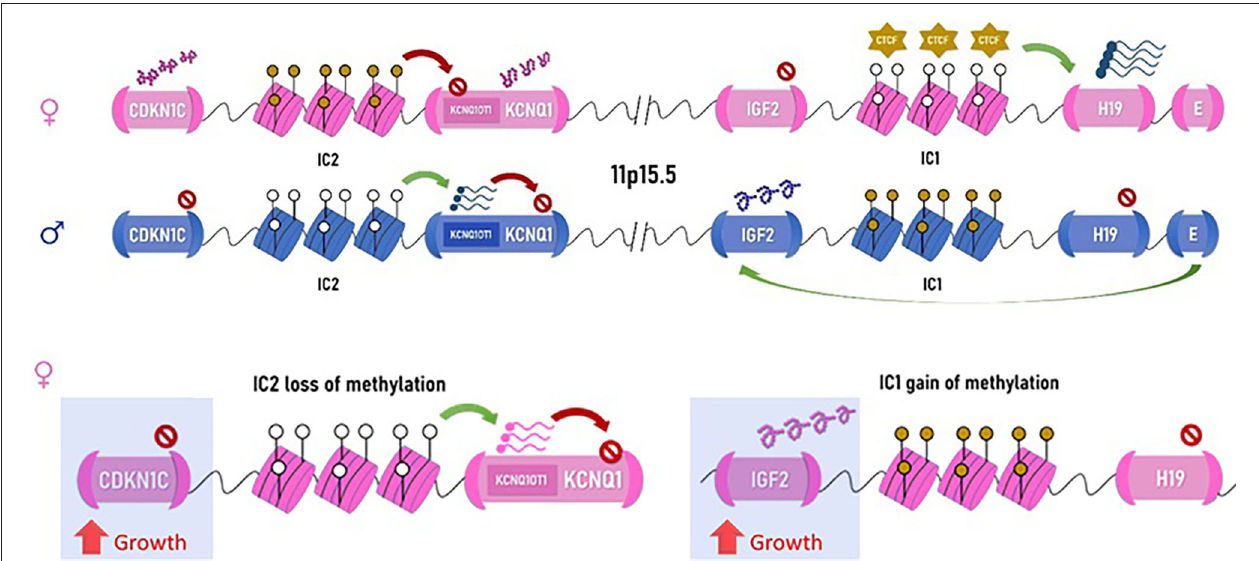
FIGURE 2 | Chromosomal arrangement of the 11p15.5 locus. Maternal allele on top (in pink) and paternal allele below (blue) are represented. IC1, imprinting center 1, attracts the non-methylated form CTCF (transcription repressors of the CCCTC-binding family), which activates transcription of H19, a non-coding RNA, which represses growth. When the imprinting center is methylated, as normally occurring on the paternal allele, H19 is not transcribed, and the downstream enhancer elements can act on IGF2, which similar to IGF-1, promotes growth, particularly in the perinatal phase. Imprinting center 2 represses the expression of the potassium channel gene, KCNQ1 , via transcription of its antisense (KCNQ1OT1) and the nearby CDKN1C , a growth-repressing cycline. Therefore, when IC2 is methylated, as seen on the maternal allele, CDKN1C is expressed, and growth is attenuated. On the paternal allele, IC2 is not methylated, and CDKN1C along with KCNQ1 are repressed, allowing growth. Either via expression of IGF2 or silencing of CDKN1C, the paternal allele promotes growth. Hypermethylation of IC1 on the maternal allele resulting in IGF2 overexpression is the mechanism seen in the patient in Figure 1 (right). This causes the maternal allele to function similar to the paternal allele, resulting in overgrowth with macroglossia. Loss of methylation of the maternal IC2 resulting in CDKN1C repression will also result in BWSp. Note: IC2 is depicted in this figure in juxtaposition to the KCNQ1 gene for simplification; its true position is within the KCNQ1